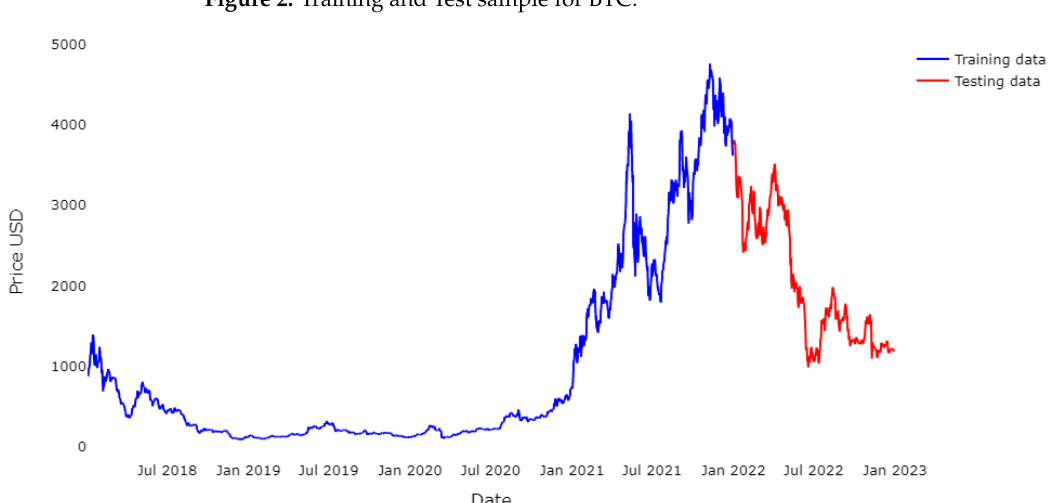
Figure 2. Training and Test sample for BTC.